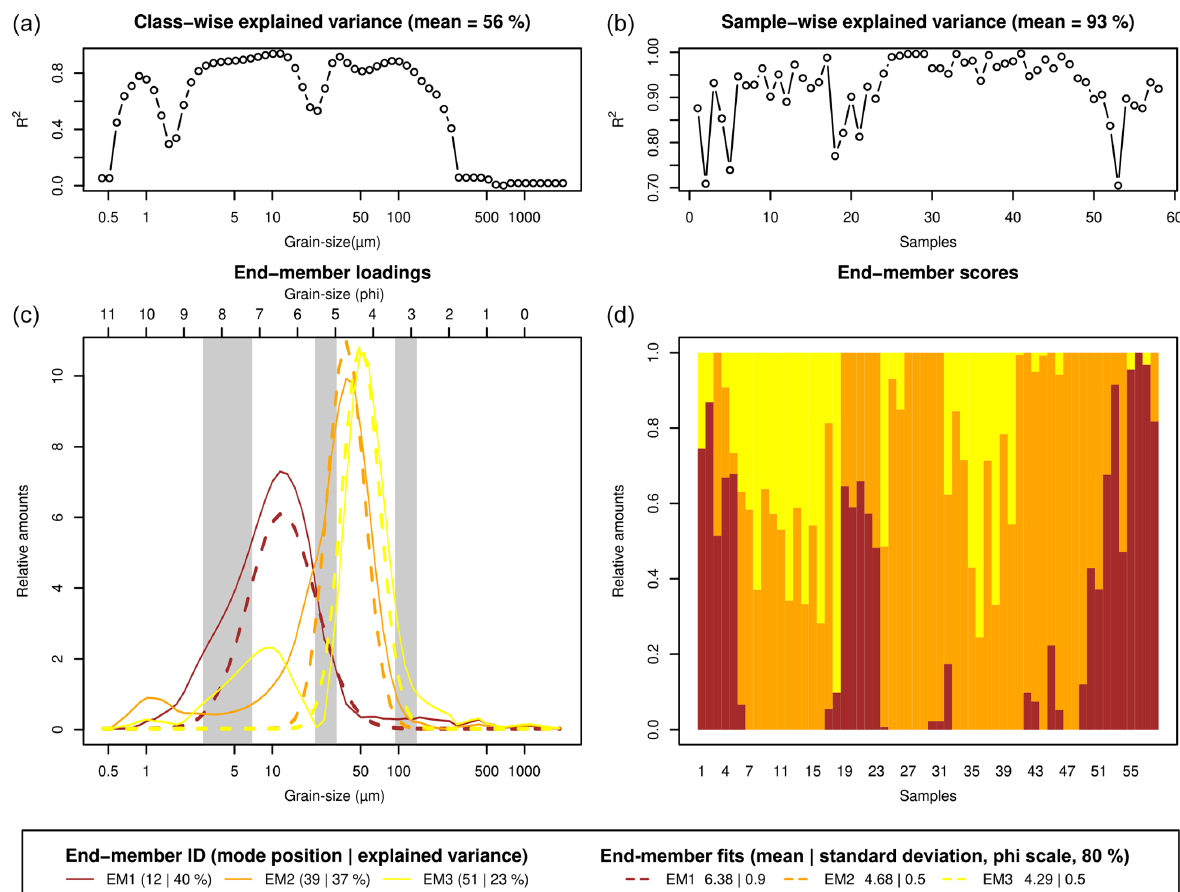
Figure 2. End-member modelling results of the measured grain-size data of the Gleina section. Dashed lines in the loadings plot show fitted log-normal distribution curves according to the parameters in the bottom legend panel. Grey shaded areas in the loadings panel depict grain-size intervals used for sieving to enrich individual end-members. Sample IDs in the scores plot denote samples from top to bottom.